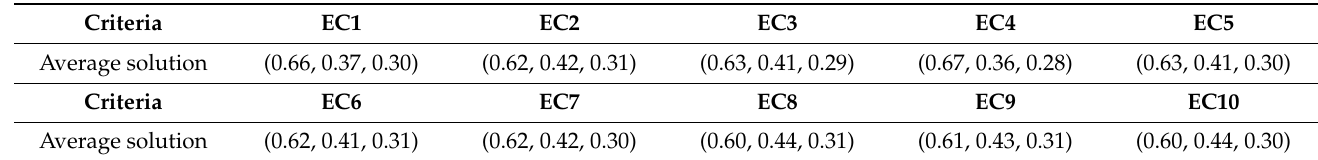
Table A7. Spherical fuzzy average solution.